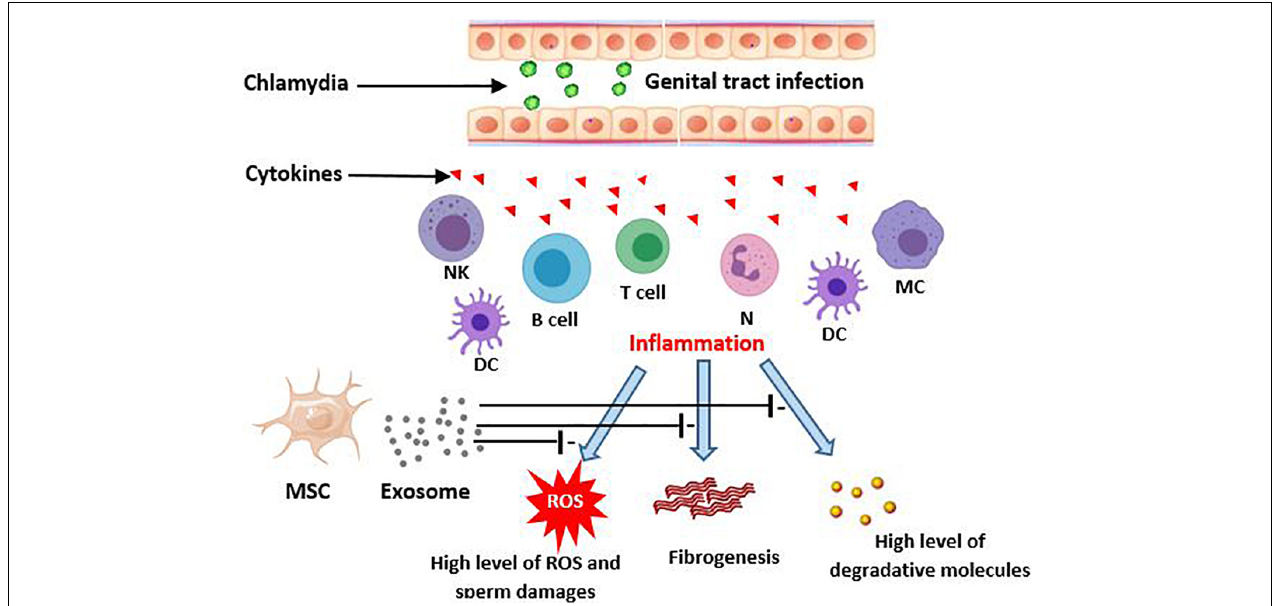
FIGURE 1 | Potential effects of MSCs-derived exosomes on consequences of chlamydia infection in the genital tract. Genitalia tract infection with chlamydia evokes an inflammatory immune response by epithelial and local immune cells. This, in turn, produces the high level cytokins that initiate a more severe immune reaction. The responses may result in male genital inflammation and fibrosis. On the other hand, the inflamed tissue can lead to creation of ROS production and then sperm damages. MSC derived exosomes potentially improve these consequences of chlamydia induced inflammation. DC, Dendritic cells; MC, Macrophage; NK, Natural killer; MSC, Mesenchymal stem cell; ROS, Reactive oxygen species.